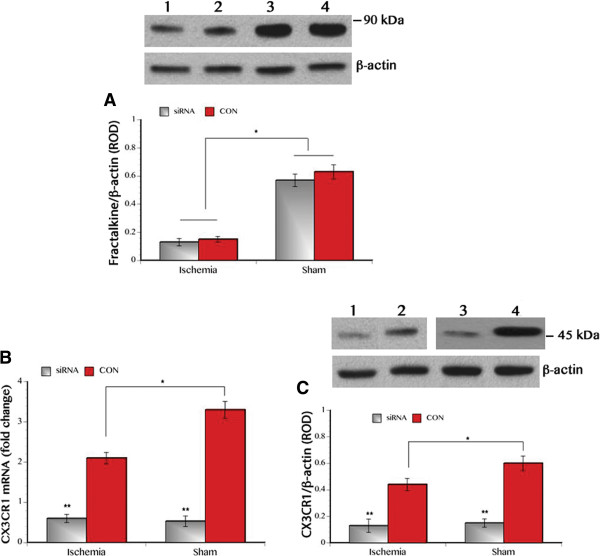
Transient global cerebral schemia decreases fractalkine/CX3CR1 Expression. (A) Decreased fractalkine expression was detected in the hippocampus of ischemic rats in comparison to the sham animals. Upper panel shows representative western blot. (B) Real-time polymerase chain reaction was used to validate the efficacy of siRNA delivery by measuring CX3CR1 mRNA in the hippocampus. Both ischemia and sham rats that received the siRNA showed significant decrease in CX3CR1 gene expression compared to the ischemia control and sham control groups, respectively. But ischemic control rats also showed decrease CX3CR1 gene expression when compared to the sham control animals. (C) Similar pattern of expression was seen when CX3CR1 protein was evaluated as seen in both the bar graph and representative western blots (upper panel). Legends: 1: ischemia/siRNA; 2: ischemia/control; 3: sham/siRNA; 4: sham/control. *P <0.5 and **P <0.01.